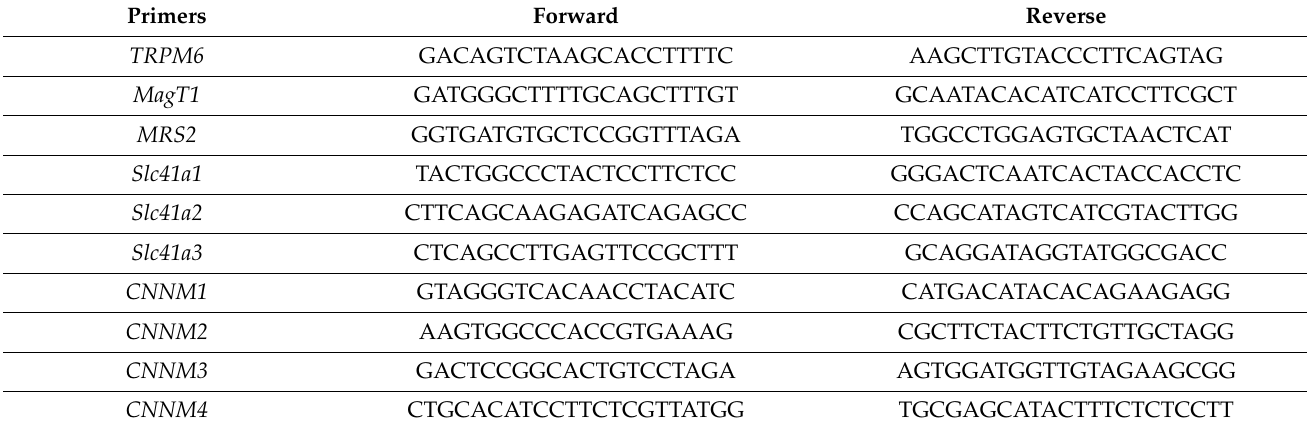
Table 1. Sequence of primers used for qRT-PCR.